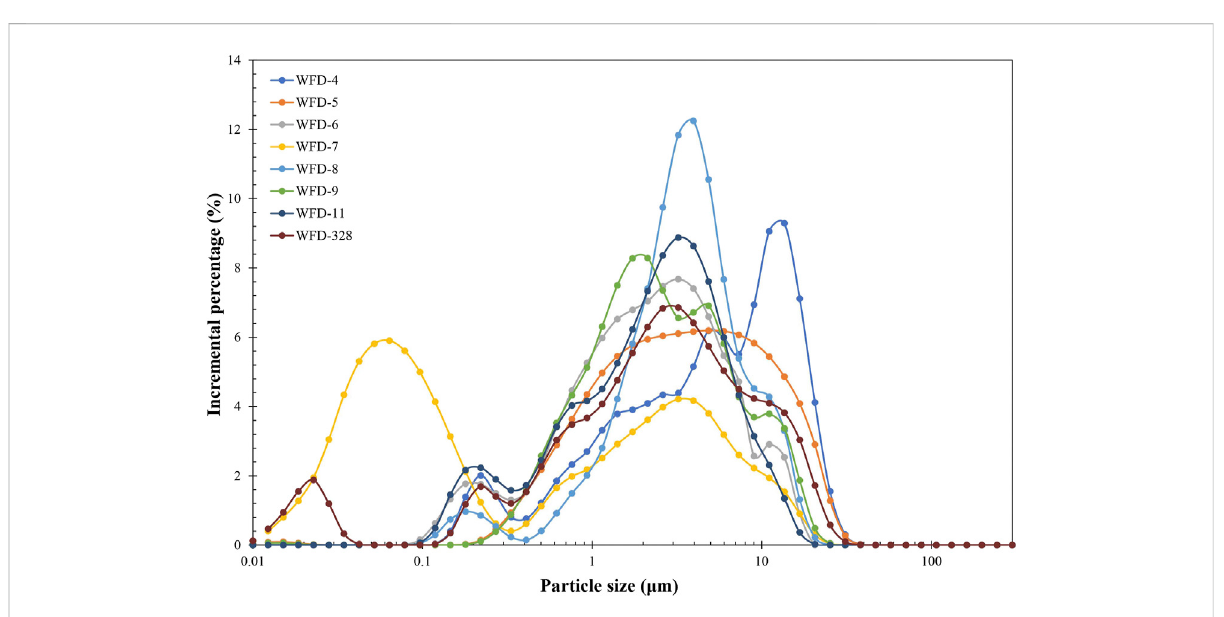
FIGURE 8 Laser diffraction-derived GSD results of eight Woodford Shale